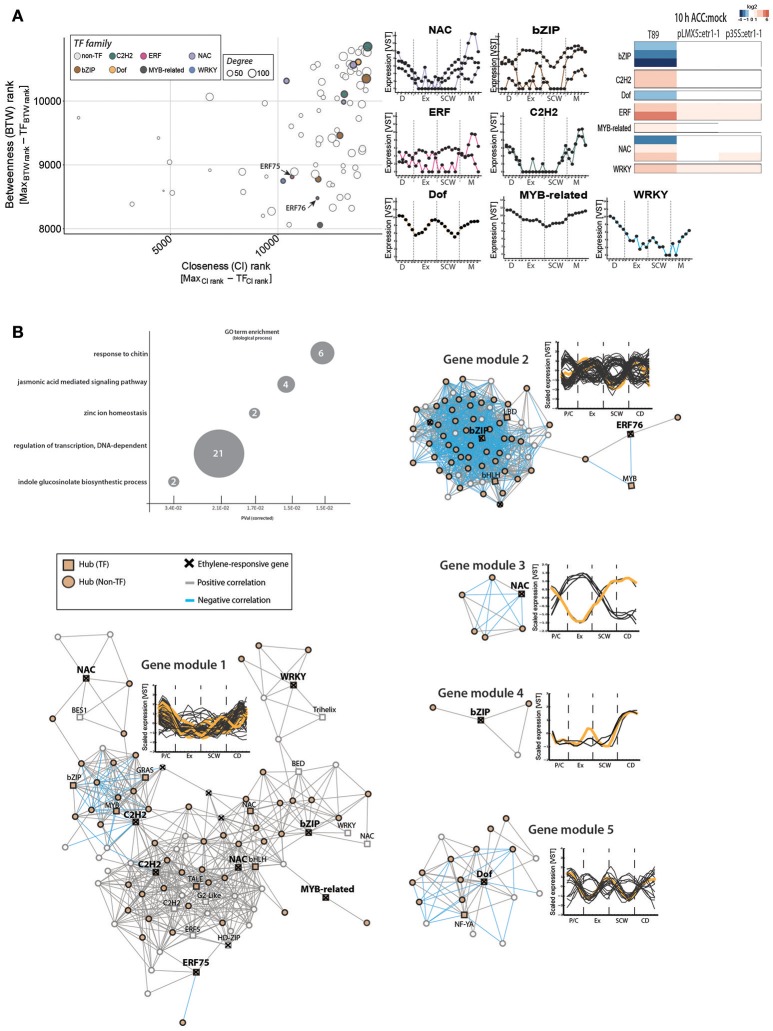
Expression of ethylene-responsive hub TFs is associated with immunity-related phytohormone signaling during wood formation. (A) Gene centrality parameters and expression profiles of ethylene-responsive hub TFs. ACC-triggered expression values in wild type and two ethylene-insensitive trees were obtained as described in Figure 2. (B) Co-expression gene modules (threshold five) of ethylene-responsive TFs. Ethylene-responsive genes inside each gene module are marked with a cross (see Supplementary Table S7). GO term enrichment was performed with A. thaliana homologs. Number indicate number of genes belonging to this GO term found among all 150 co-expressed genes.